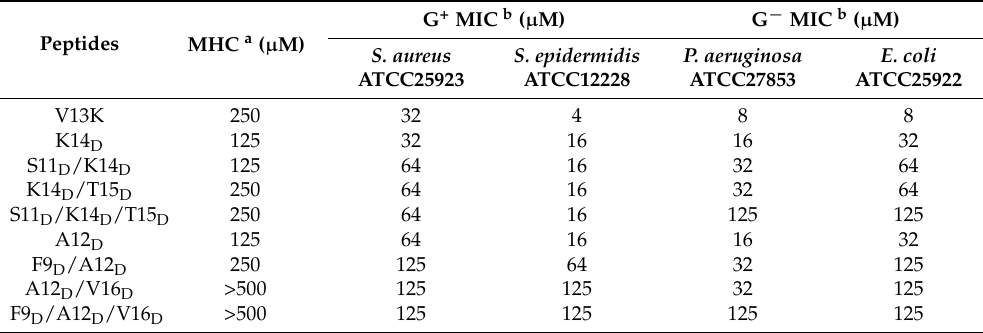
Table 3. MIC and MHC of peptides against bacteria.